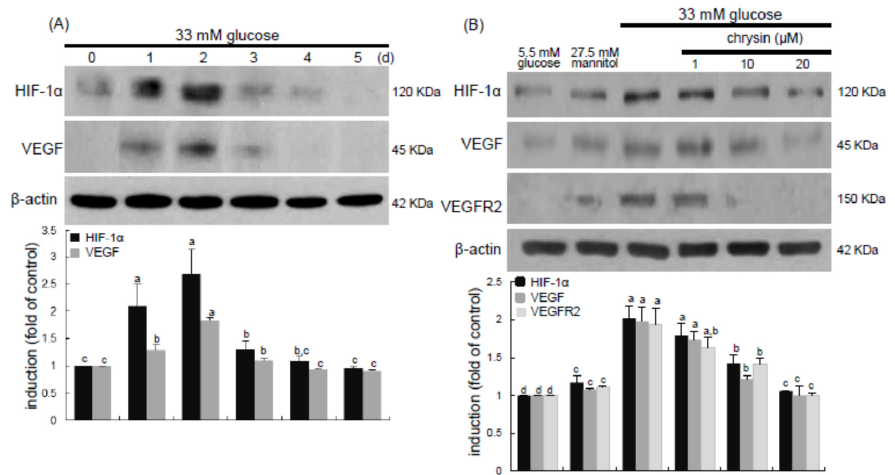
Figure 2. Time course responses of induction of HIF ‐ 1 α and VEGF by high glucose ( A ) and inhibition of HIF ‐ 1 α , VEGF, and VEGFR2 by chrysin ( B ). HRMVEC were incubated with 33 mM glucose in the absence and presence of 1–20 μ M chrysin up to five days. Cells were also incubated with 5.5 mM glucose and 27.5 mM mannitol as osmotic controls. Cell lysates were subject to Western blot analysis using a primary antibody against HIF ‐ 1 α , VEGF, or VEGFR2. β‐ Actin protein was used as an internal control. Bar graphs (mean ± SEM, n = 3) in the bottom panels represent densitometric results of upper blot bands. Means not sharing a common letter differ, p < 0.05.